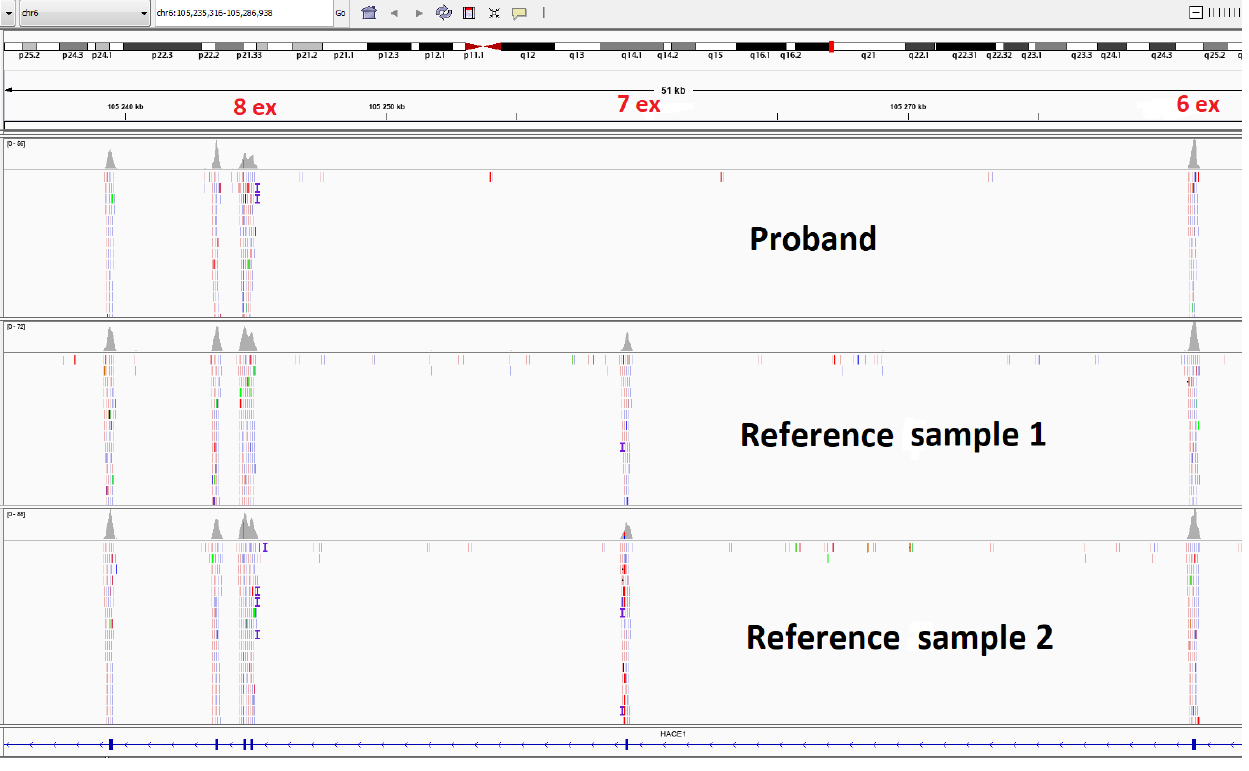
Figure 4. Molecular genetic testing of the patient by clinical exome sequencing and visualization of the homo/hemizygous deletion of HACE1 exon 7.